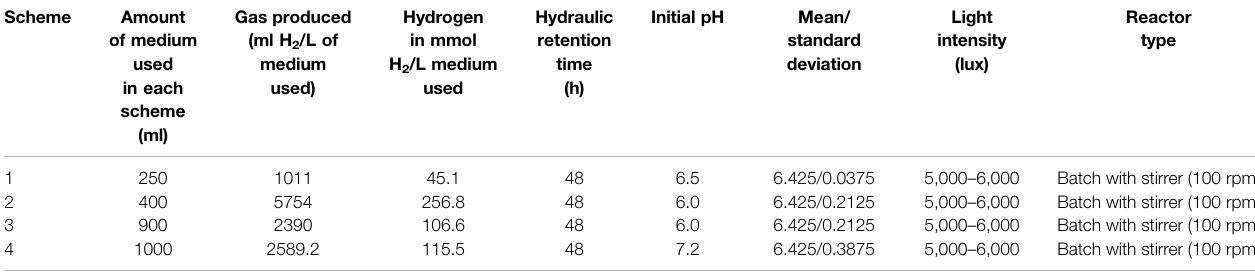
TABLE 5 | Summary of the maximum hydrogen gas produced at each experiment (scheme). Scheme